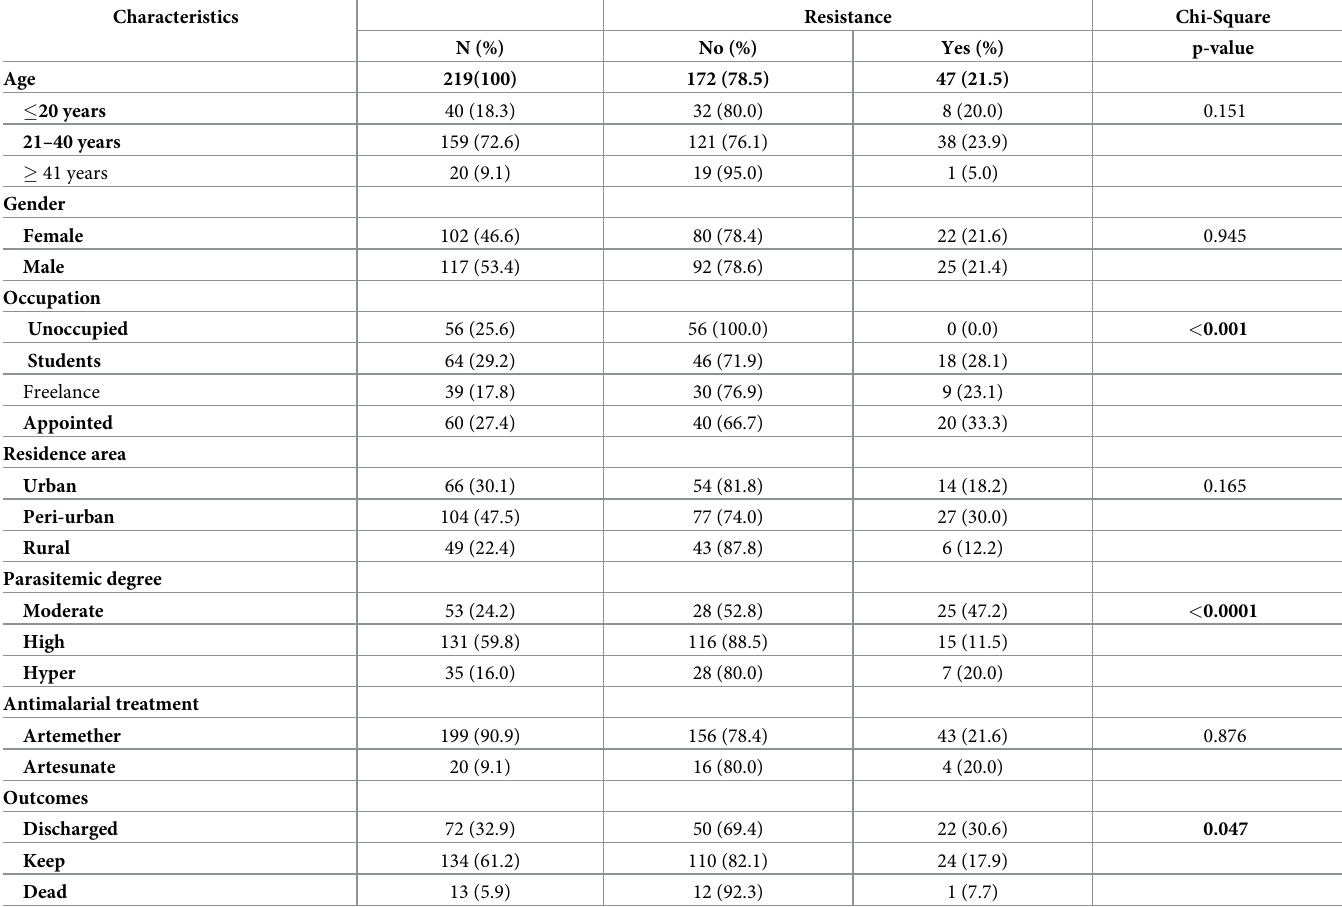
Table 1. Characteristics sociodemographic and clinical of patients with antimalarial resentence treatment in Luanda, Angola.